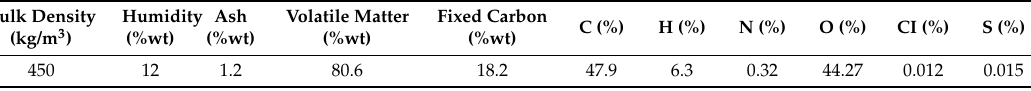
Table 3. Almond shell characterization